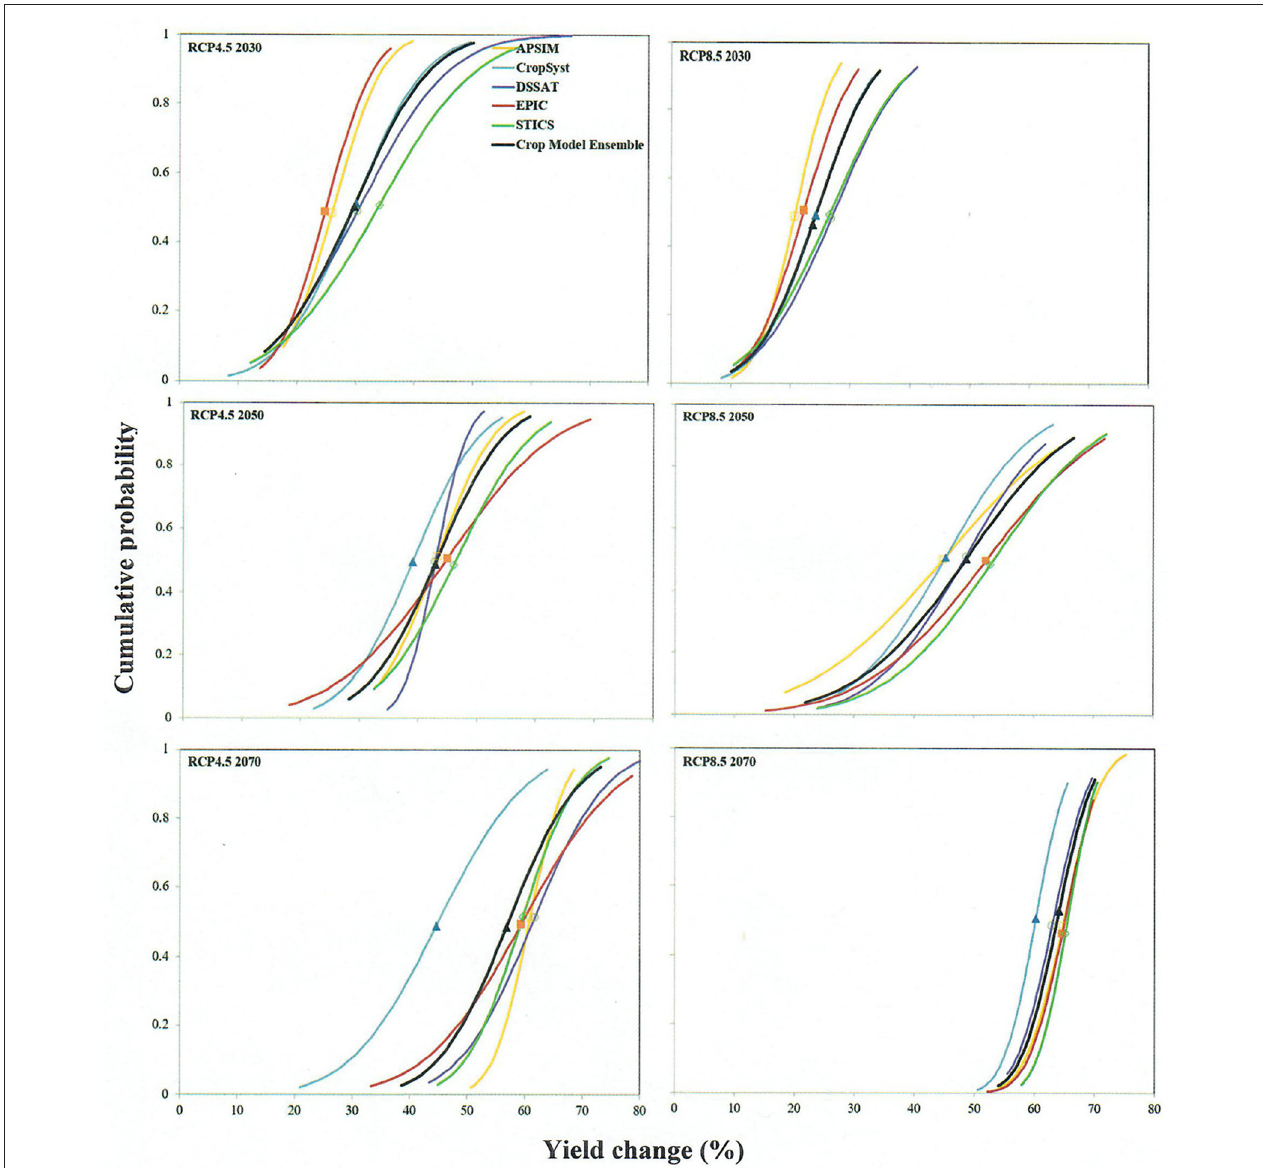
FIGURE 2 | Cumulative probability distribution for simulated winter wheat yield changes during three 31-year time periods, centered on 2030, 2050, and 2070, relative to the baseline period (1979–2010) under two representative concentration pathways (RCP4.5 and 8.5) and five crop models with ensembles of crop models at low rainfall site Lind. Symbols on curves are at the curve’s inflection point and represent the most probable yield